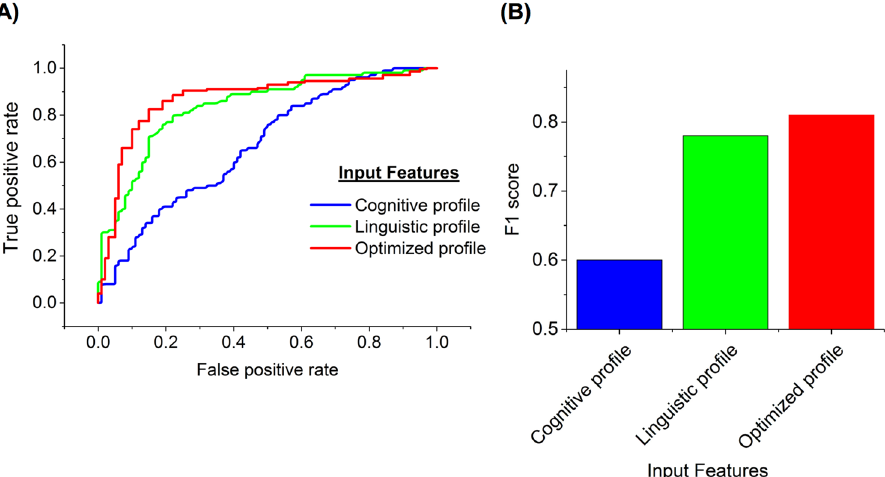
Figure 4. Random forest classifier performance for different sets of input features. ( A ) Receiver operating characteristic (ROC) curves for classifiers using three different profiles of FX premutation carriers and the comparison group. ROC curves provide a comprehensive visualization to summarize accuracy of prediction methods. The diagram shows a test’s false-positive rate (FPR), or 1 – specificity versus its sensitivity. Cognitive profile has the worst diagnostic utility, and our proposed profile has shown the best performance. ( B ) F1 score measures the test’s accuracy. It considers both precision and recall. As the F1 score approaches 1, the test has better accuracy. The proposed profile has F1 score equal to 0.81, which indicates the best performance among the tested